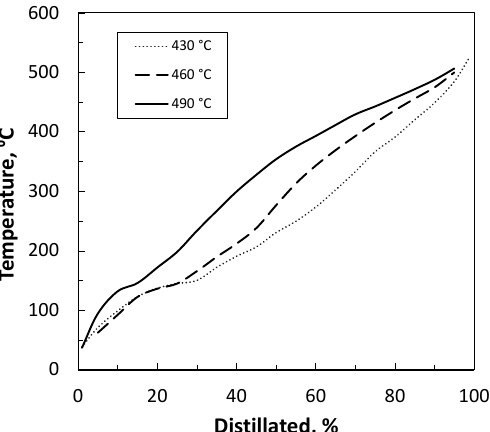
Figure 4. Composition of pyrolysis oils of PT-Film pyrolyzed at different temperatures.